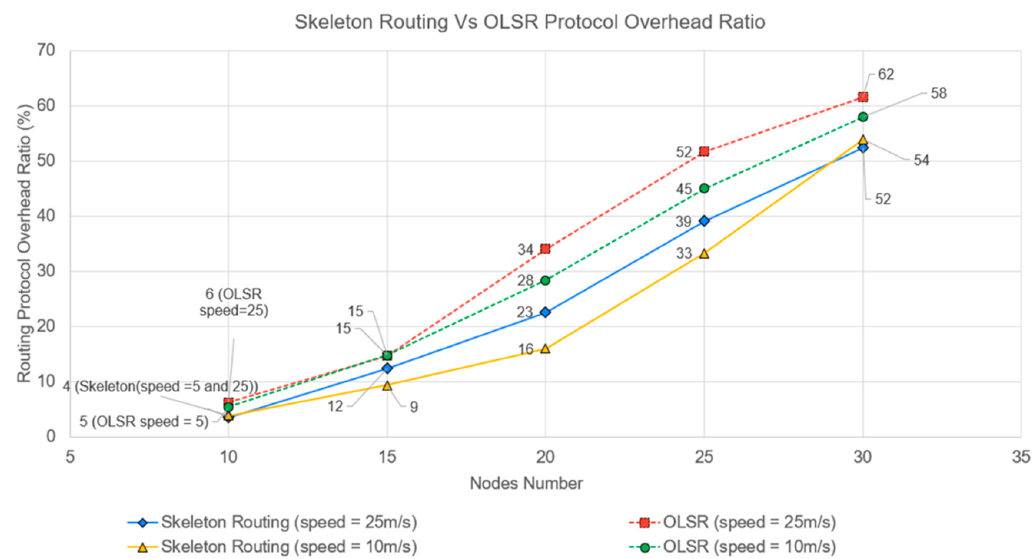
Figure 25. Protocol overhead with different network sizes and node speeds.